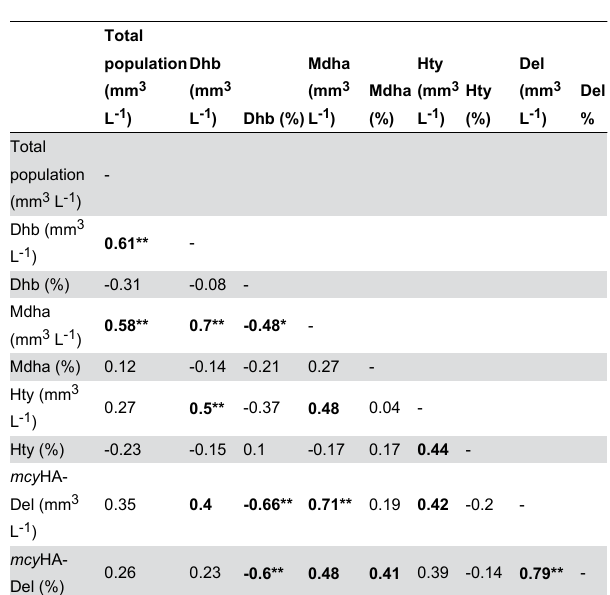
Table 2. Correlation coefficients between biovolume (mm 3 L -1 ) and the proportion of the Dhb, Mdha, and Hty genotypes and the genotype carrying the mcy HA deletion (data from